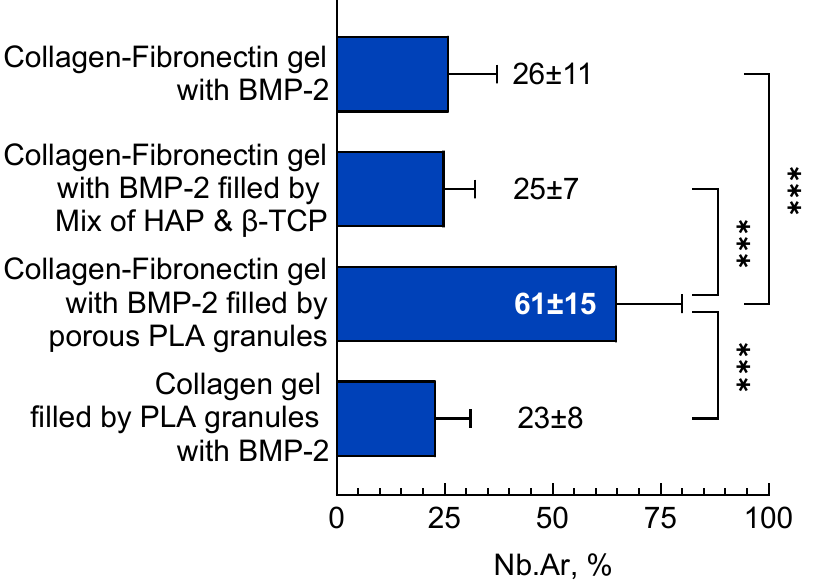
Figure 4. Newly formed bone tissue volume after implantation of different compositions into rat critical-size calvarial defects. ***— p < 0.001. Collagen-Fibronectin Gel with BMP-2 Filled with HAP/ β -TCP